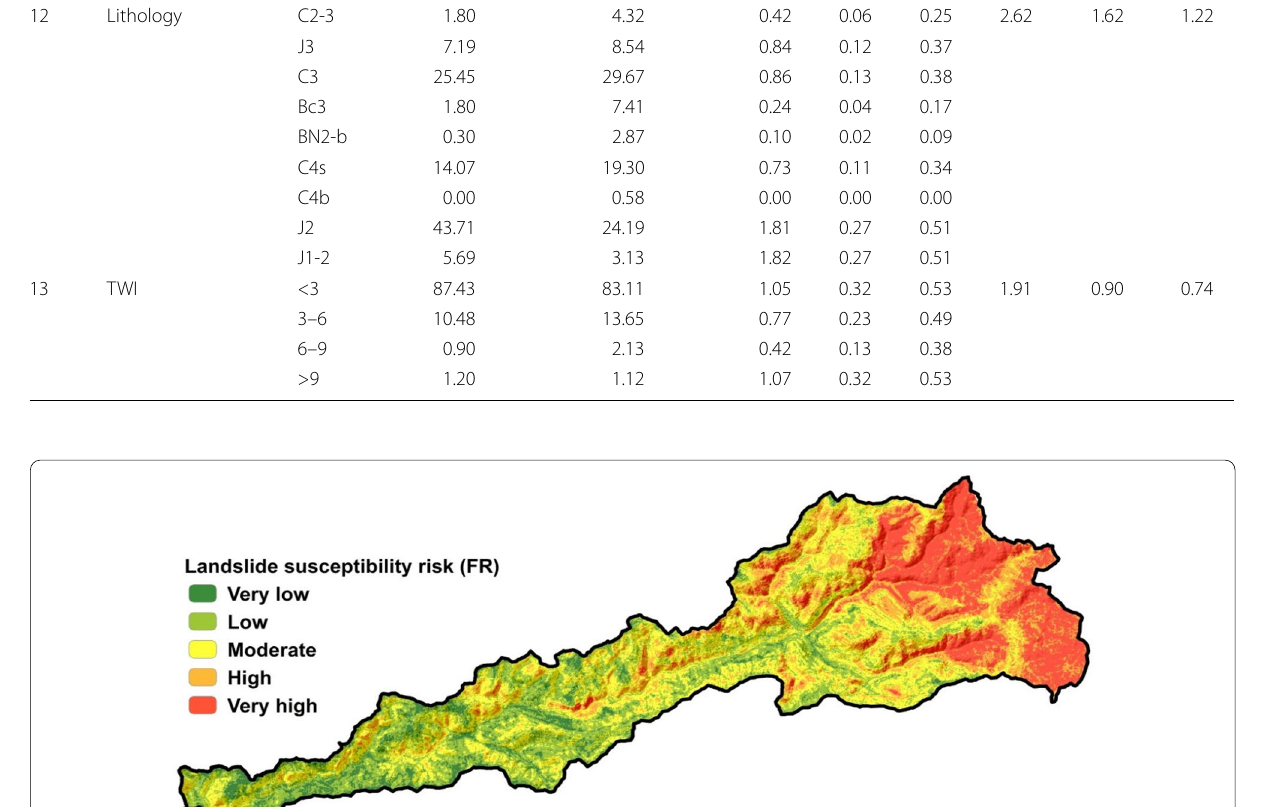
map of 446 landslide locations. However, this strategy can be relied on in most areas of CMA in generating similar inventory maps for the different types of slope material movement (Es-Smairi et al. 2022). This inventory map enabled a perfect modelling process with thirteen driving factors. The selection of causative factors is a critical task in the context of the most reasonable extraction of land- slides using bivariate statistical models (Wubalem et al. 2022). The fieldwork carried out showed the diversity of landslide patterns, including rainfall-induced rapid mass movements, rock falling, bouncing and rolling, shal- low landslides and debris and mud flow. These patterns represent a direct reflection of the complex interaction